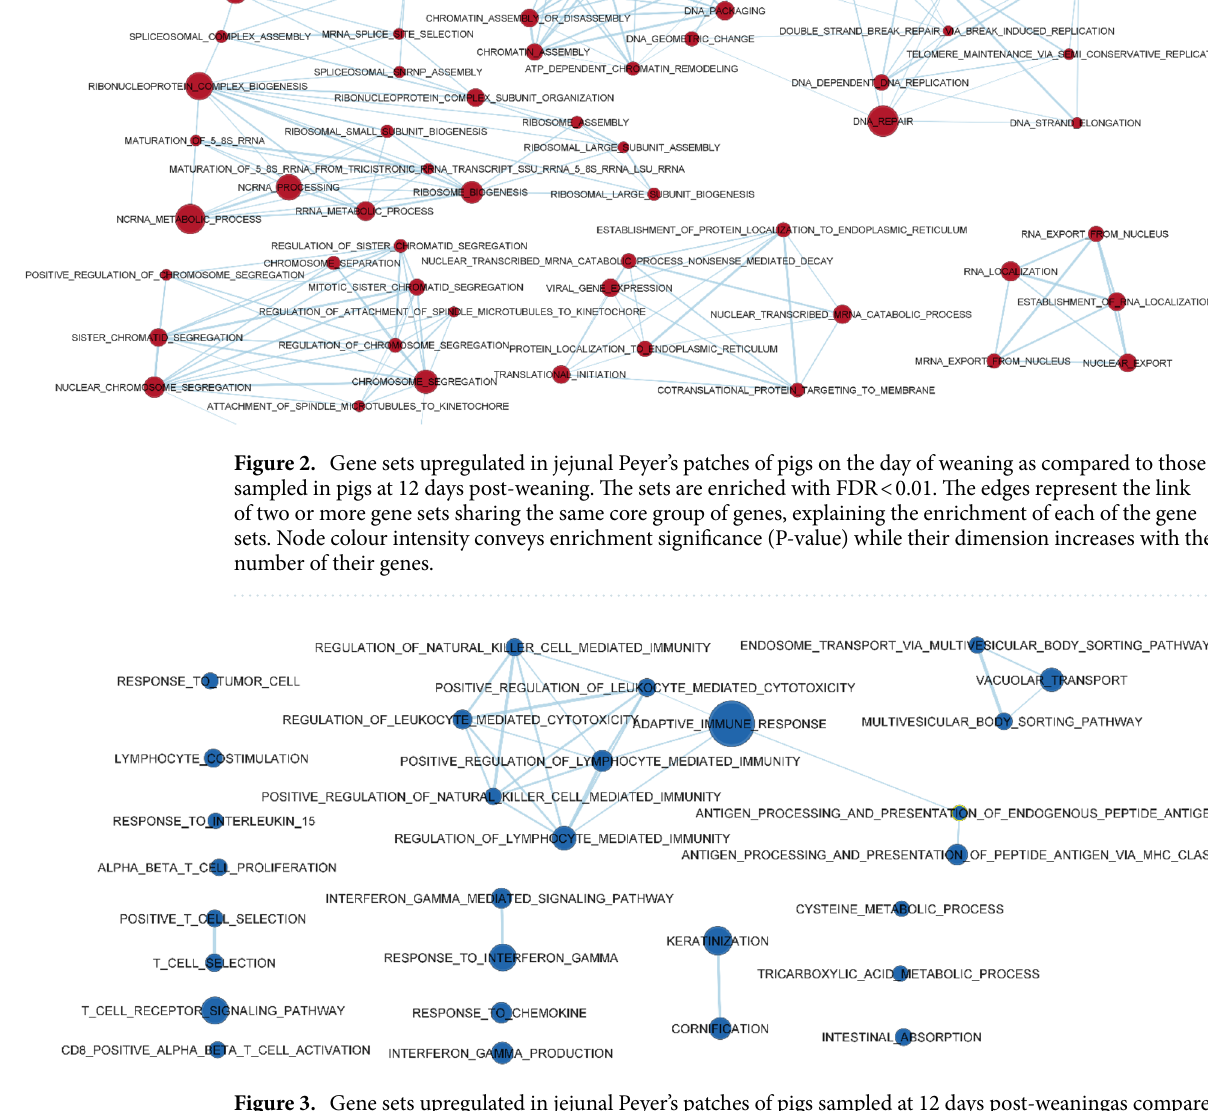
Figure 3. Gene sets upregulated in jejunal Peyer’s patches of pigs sampled at 12 days post-weaningas compared to those on the day of weaning. The sets are enriched with FDR < 0.05. The edges represent the link of two or more gene sets sharing the same core group of genes, explaining the enrichment of each of the gene sets. Node colour intensity conveys enrichment significance (P-value) while their dimension increases with the number of their